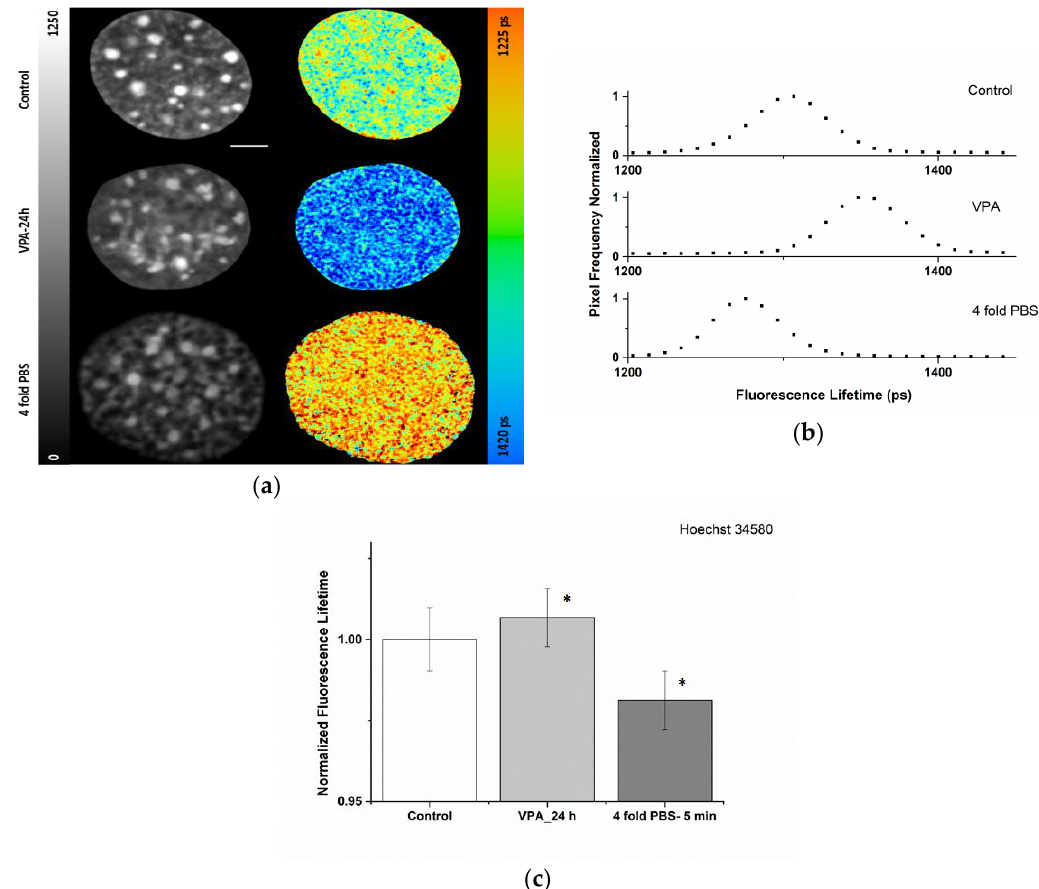
Figure 1. Modulation of the chromatin density of living NIH/3T3 cells stained with Hoechst 34580 and evaluation by fluorescence lifetime imaging microscopy (FLIM): ( a ) Intensity (left) and color coded lifetime images (scale ranging from 1225 to 1420 ps) of controls (upper row), upon treatment with histone deacetylase inhibitor, VPA, for 24 h (middle), or 4-fold Phosphate Buffer Saline (PBS, bottom). For 4-fold PBS chromatin compaction becomes obvious also in the intensity image showing the formation of condensed structures. Lookup table (LUT) at left side indicates corrected photon counts (0 – 1250). The fluorescence lifetime is shown in a continuous pseudo-color scale (right) ranging from 1225 to 1420 ps ( b ) Normalized frequencies of lifetime distributions from the nuclei of ( a ). Scale bar, 5 µm. ( c ) Quantification of relative Hoechst 34580 lifetime changes observed after histone deacetylase inhibitor (VPA) or hyperosmolarity (4-fold PBS). n = 20 for each condition. The lifetime values were normalized to control values. Asterisk (*) shows p < 0.05 (using Student’s t -test) compared to control. Error bars indicate mean ± SD.